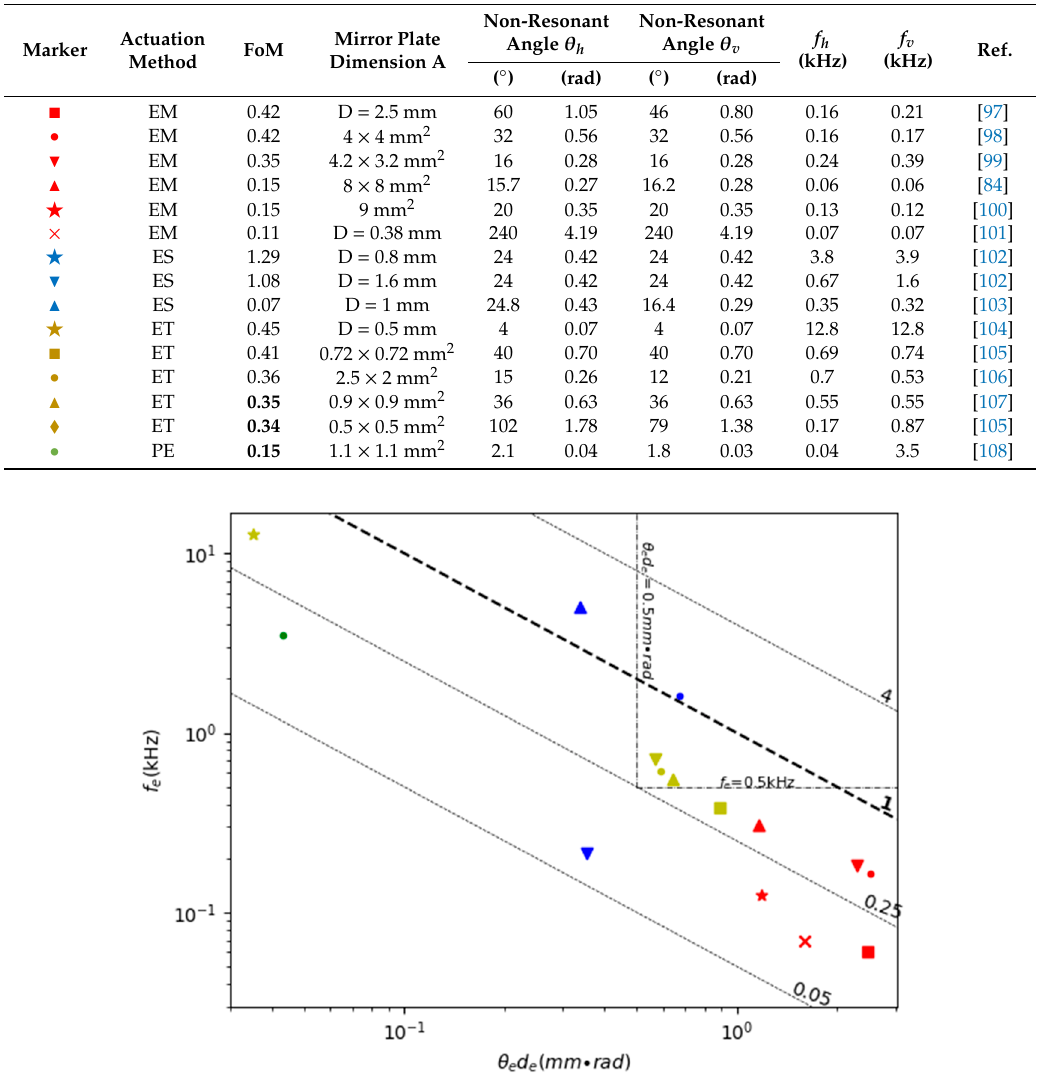
Figure 12. A comparison of 2D non-resonant scanning MEMS mirrors.